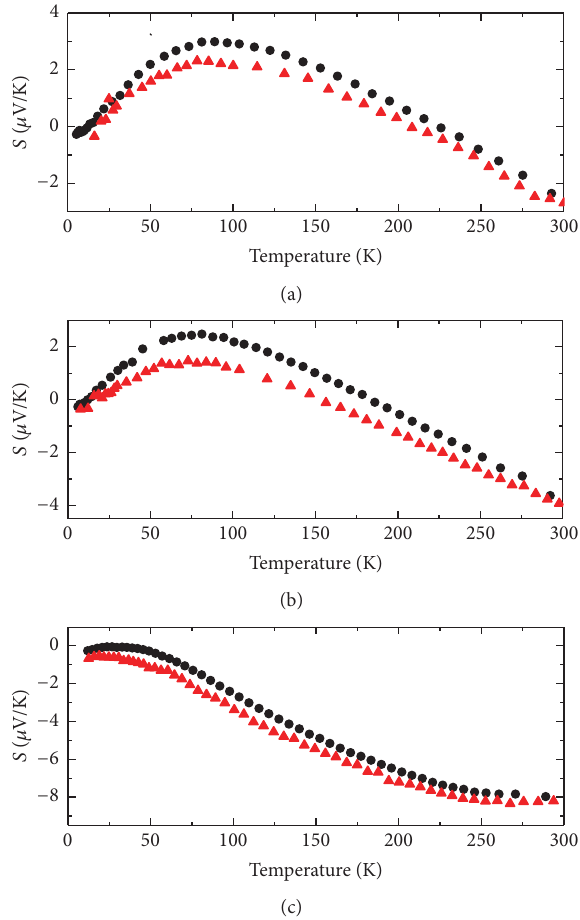
Figure 1: Plot of the thermopower from Sr 2−𝑥 La 𝑥 FeMoO 6 with (a) 𝑥 = 0.4 , (b) 𝑥 = 0.2 , and (c) 𝑥 = 0 at 0 T (filled circles) and 6 T (filled up triangles).